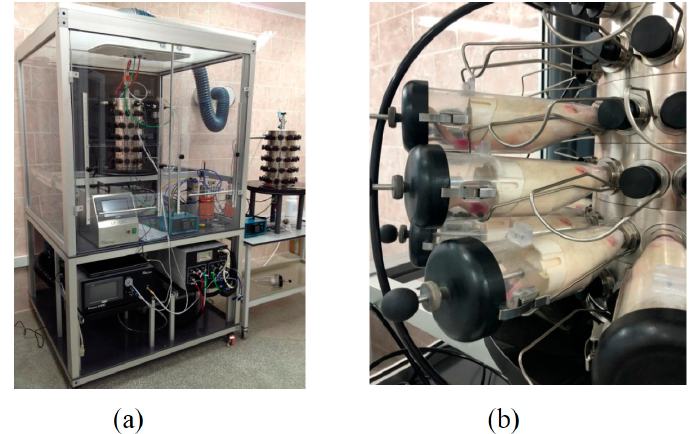
Figure 8. ( a ) The nose-only inhalation device (photographed without door wings of the draught cupboard) and, in the background, a similar tower for the sham exposure of the control group; ( b ) restrainers with rats attached to the exposure tower.